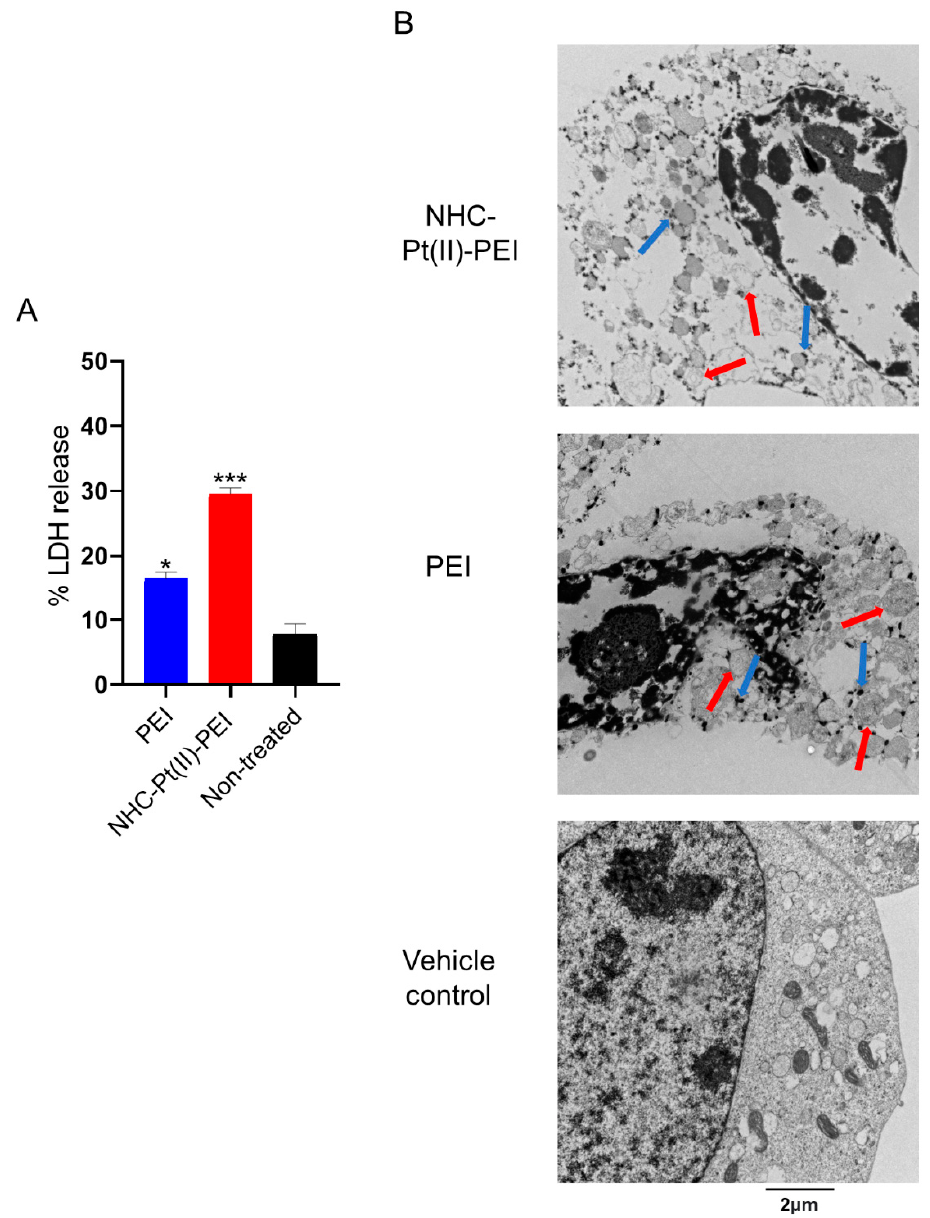
Figure 6. LDH release and necrotic, vacuolised cell death morphology of 6 h 5 µM NHC-Pt(II)-PEI and 5µM PEI eq treated NCH421K spheroids. ( A ) Histograms showing quantified LDH activity of cell supernatant as a percentage of the activity of lysed non-treated cells. Values represent the mean of at least n = 3 independent experiments ± one SEM. Statistics represent Student’s t -tests versus the non-treated condition. Distribution normality was confirmed using a Shapiro–Wilk test. * = p ≤ 0.05, *** = p ≤ 0.001. ( B ) Representative TEM images of the treated cells at 15,000× magnification. Red arrows = Double membraned vesicles. Blue arrows = Purported lysosomes.